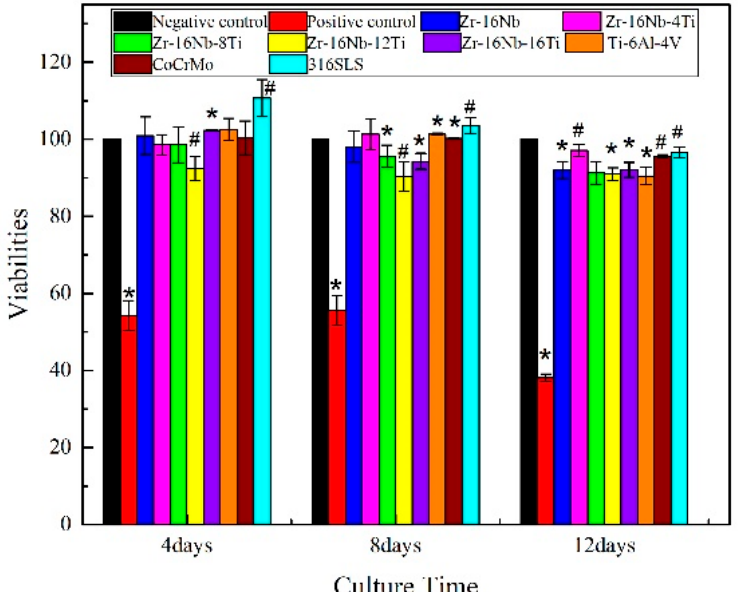
Figure 8. Viabilities of MG63 osteoblast-like cells, which were cultivated in the extracted media of Zr-16Nb-xTi, Ti-6Al-4V, Co-Cr-Mo and 316L SS for 4, 8 and 12 days. #, * indicates p < 0.05 and p < 0.01, respectively, compared with the negative control.